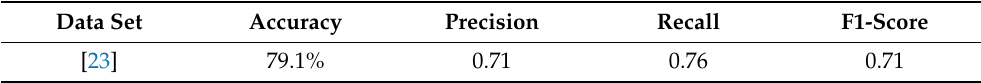
Table 4. Evaluation Results.